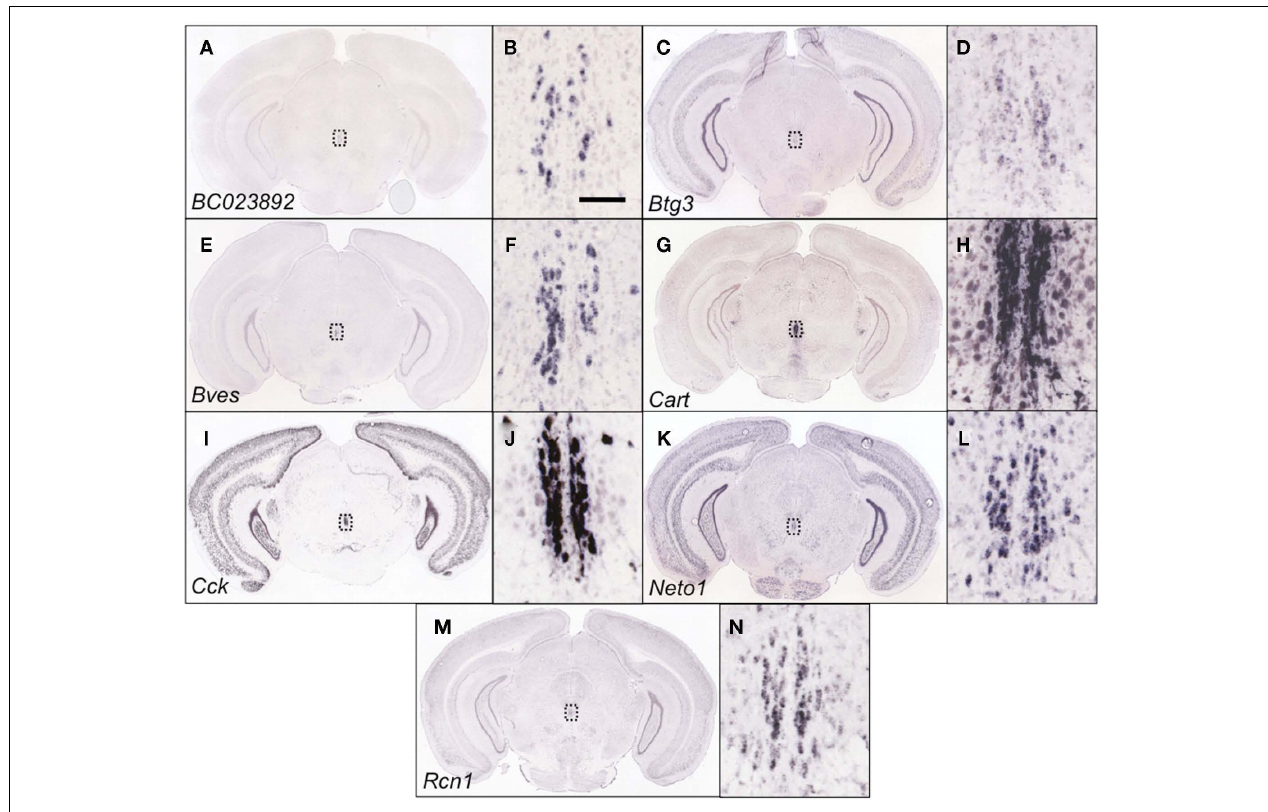
Rcn1 (M) .The close-up images (B,D,F,H,J,L,N) show the area within the dotted line of the corresponding figure, indicating that BC023892 , Btg3 , Bves , Cart , Cck , Neto1 , and Rcn1 demonstrate an EWcp-specific pattern of expression. Scalebar = 100 μ m, and is valid for all close-up images. Images courtesy of the Allen Brain Atlas, used with permission.